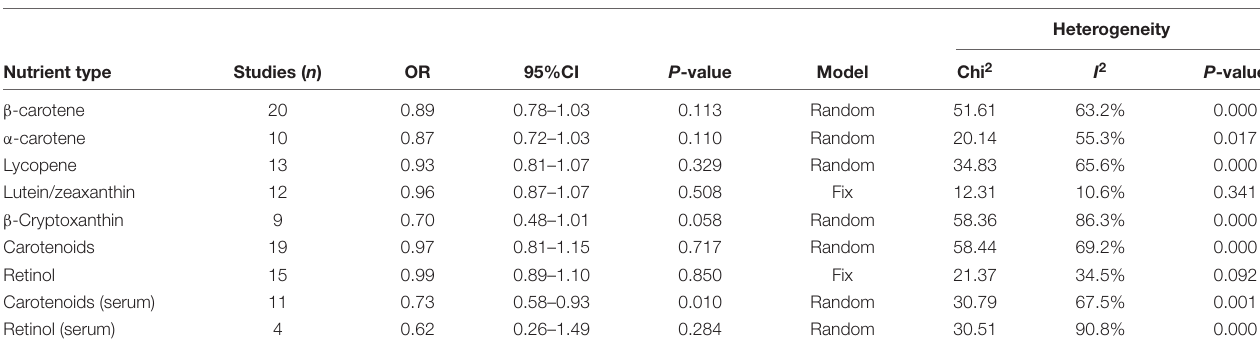
FIGURE 6 | Forest plot of serum carotenoid and retinol concentrations and colorectal cancer risk. (A) serum carotenoid; (B) subgroup analysis of serum carotenoids according to their types; (C) serum retinol; (D) subgroup analysis of serum retinol by study type. TABLE 2 | Meta-results on intake of various nutrients and colorectal cancer